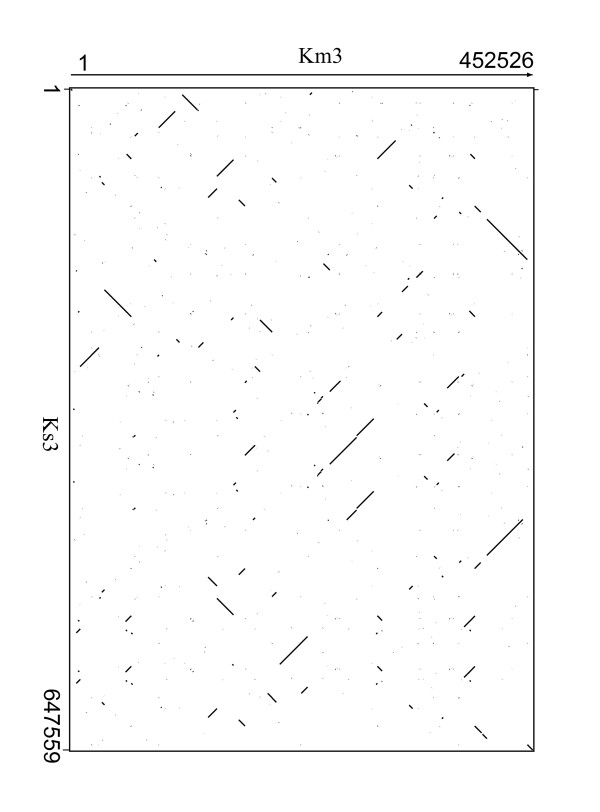
Dot matrix alignment of the Km3 (x-axis, 1-452526) and Ks3 (y-axis, 1-647559) mtDNAs.